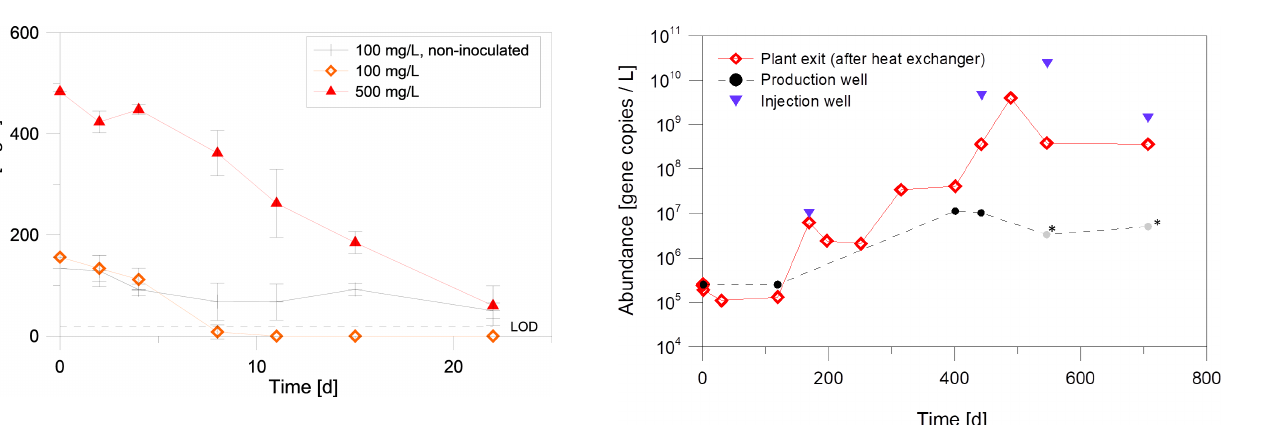
Figure 4. Quantification of the inhibitor in degradation experiments with different initial concentrations via UV/VIS. One set of exper- iments (black line) had not been inoculated. Each data point was obtained from four independent samples. LOD (limit of detection): 10mg/L.